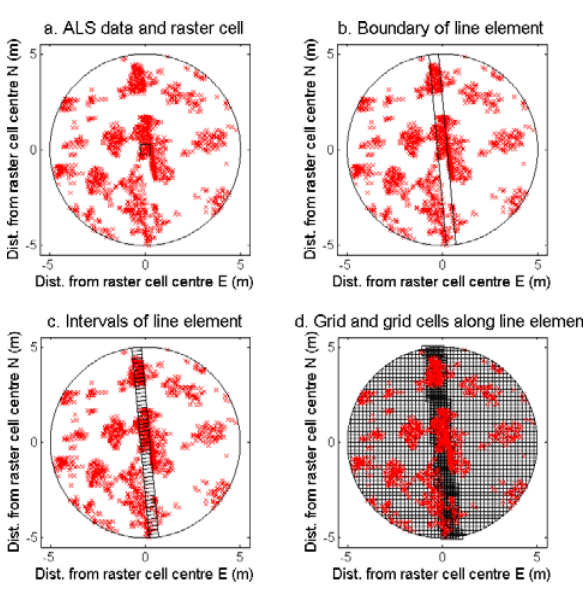
Figure 3. Example of line template matching in case of low vegetation and no lying tree stem measured in field. ALS data between ≥0.2 m and ≤1.0 m above the DTM are shown in